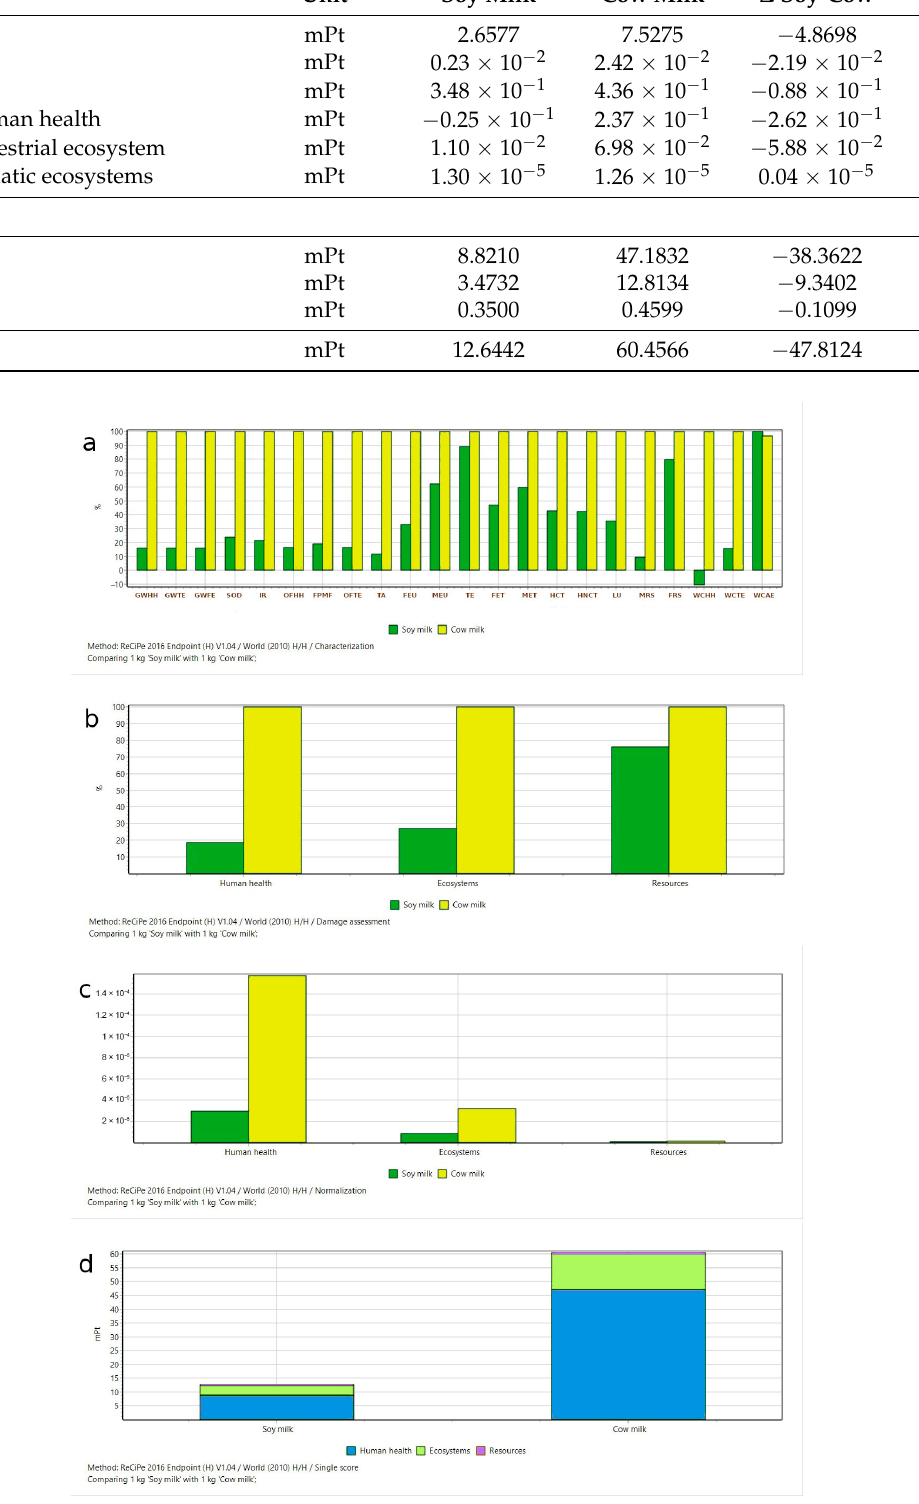
Figure A5. Comparison between Soy Milk and Cow Milk: ( a ) Characterization; ( b ) Damage Assess- ment; ( c ) Normalization; ( d ) Aggregated Weighted Average (Single Score). GWHH: Global warm-